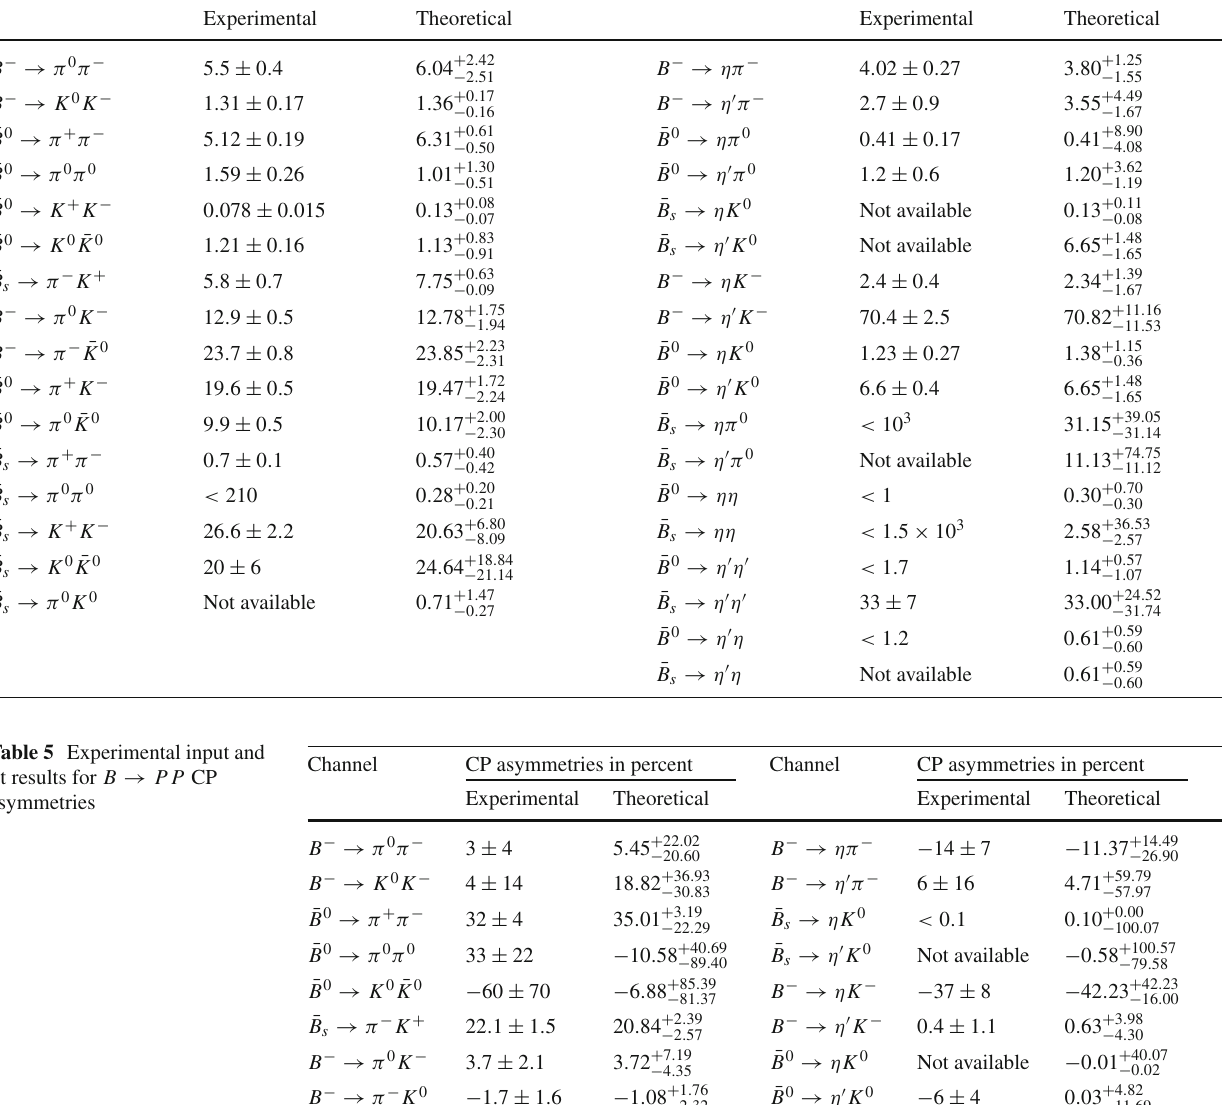
Table 4 Experimental input and fit results for CP-averaged B → PP branching fractions Channel Branching ratio in units of 10 − 6 Channel Branching ratio in units of 10 − 6 Experimental Theoretical Experimental